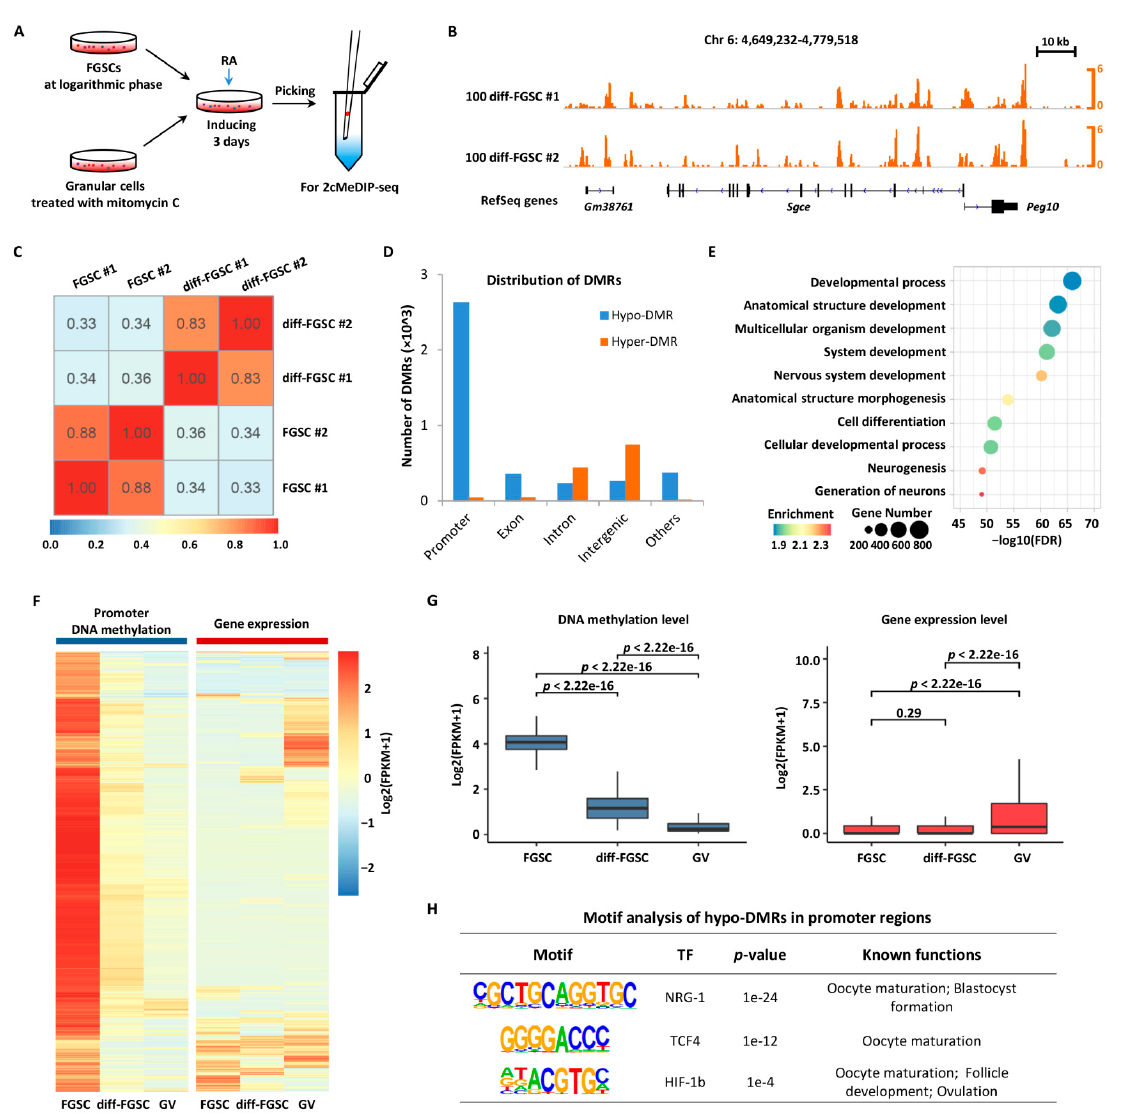
Figure 6. Distinct DNA methylation patterns during FGSC differentiation. ( A ) Experimental design and DNA methylation data generated with differentiated FGSCs. FGSCs were treated with RA for 3 days and collected for 2cMeDIP-seq. ( B ) Normalized 2cMeDIP-seq signals generated with 100 differentiated FGSCs are shown for the indicated region. ( C ) Heatmap showing the methylation signals correlation between the undifferentiated and the differentiated FGSCs. The correlation coefficient was calculated in non-overlapping 10 kb windows across entire genome. ( D ) The bar chart showing the numbers of DMRs distributed in distinct genomic regions of differentiated FGSCs when compared with the undifferentiated FGSCs [FDR (false discovery rate) < 0.001]. ( E ) GO analysis of genes with hypo-DMRs in promoter regions. The color and the dot size represent the enrichment levels and the number of DMR-associated genes within each GO term, respectively. ( F ) DNA methylation and expression analysis of genes with hypomethylated promoters. ( G ) Boxplots of DNA methylation or gene expression levels of the genes with hypomethylated promoters in FGSCs, diff-FGSCs, and GV oocytes. ( H ) Motifs analysis of hypomethylated DMRs in promoter